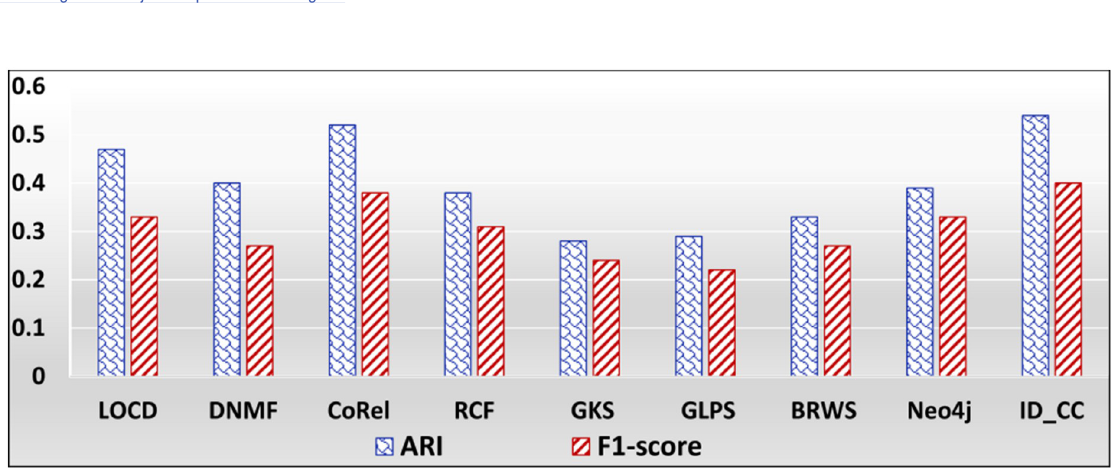
Fig 28. The overall average accuracy of each method for detecting the Friendster cross-communities in terms of ARI and F1-score.